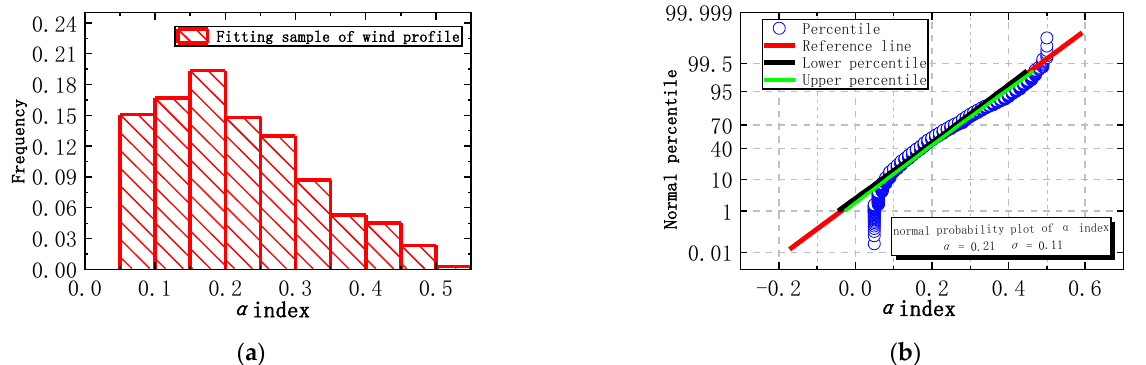
Figure 6. Sample distribution of wind profile index: ( a ) α histogram of exponential frequency distribution; ( b ) normal probability plot of the α index.